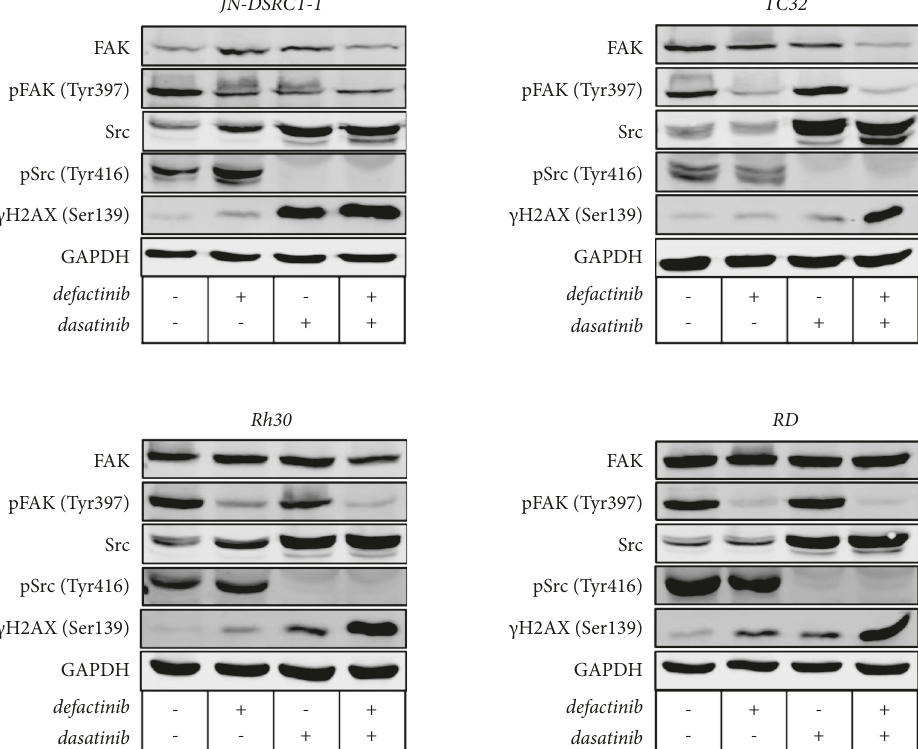
Figure 2: (p)FAK, (p)Src expression, and DNA damage ( c H2AX) following defactinib and dasatinib combination treatment in DSRCT, ES, ARMS, and ERMS cell lines. FAK, pFAK (Tyr397), Src, pSrc (Tyr416), c H2AX (Ser139), and GAPDH expressions at baseline, post-24-h single-agent defactinib or dasatinib treatment, and post-24-h combination treatment with defactinib and dasatinib in the JN-DSRCT-1, TC32, Rh30, and RD cell lines assessed by Western blot analysis.